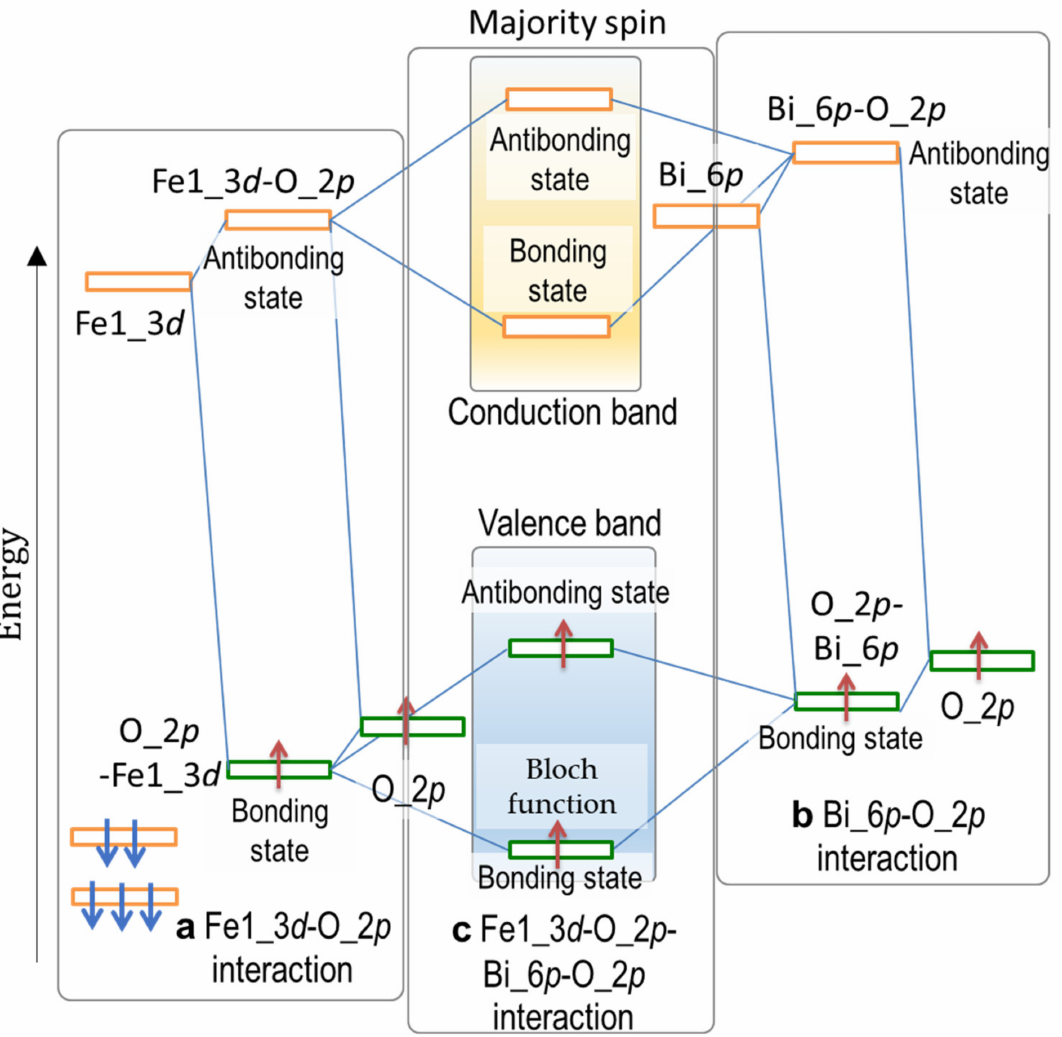
Figure 5. Orbital interactions delivering the Bloch function of the majoring spin ( ↑ ) band shown in Figure 4 of the rhombohedral BiFeO 3 ( x = 0): ( a ) Fe1_3 d –O_2 p mixing leading to a bonding state in the valence band and an antibonding state in the conduction band; ( b ) Bi_6 p –O_2 p mixing resulting in a low-lying bonding state and a high-lying antibonding state; and ( c ) hybridization between Fe1_3 d –O_2 p and Bi_6 p –O_2 p leading to the Bloch function at a deep level in the valence